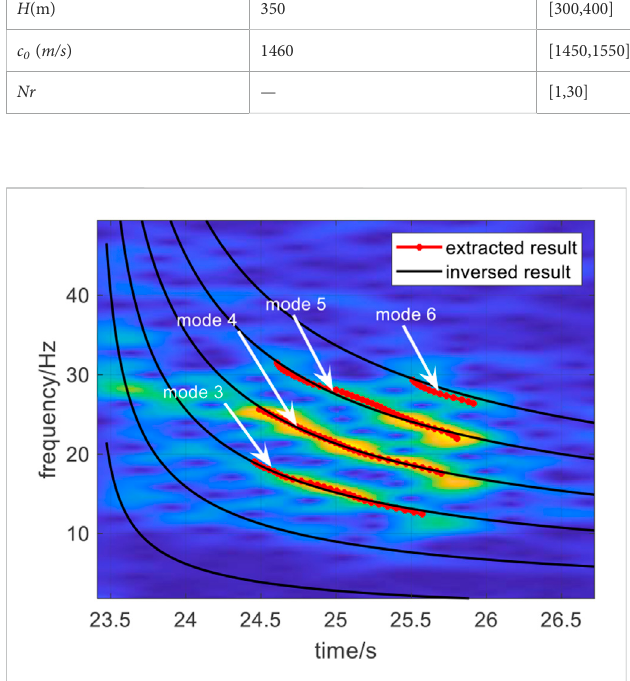
FIGURE 15 Mode determination results and dispersion curve comparison results of data